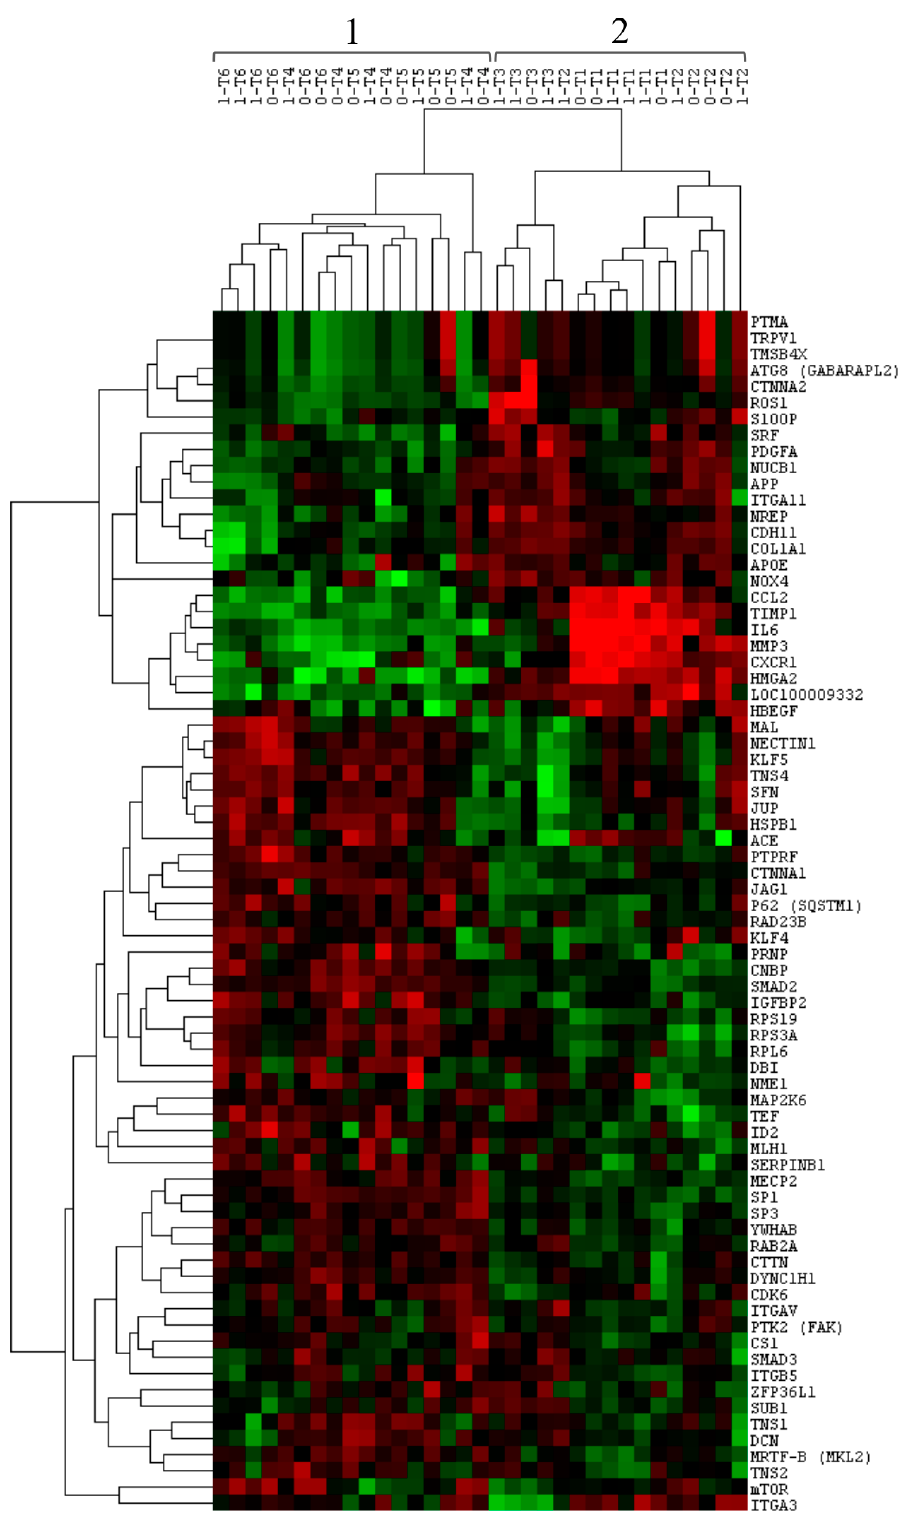
Figure 3. Hierarchical clustering analysis of post ‐ extractive socket samples using the 74 differentially expressed genes from the custom panel. The two main clusters are indicated with the numbers 1 and 2. The columns represent the samples, and the lines represent the genes. Red color indicates high gene expression levels; green color indicates low gene expression levels.